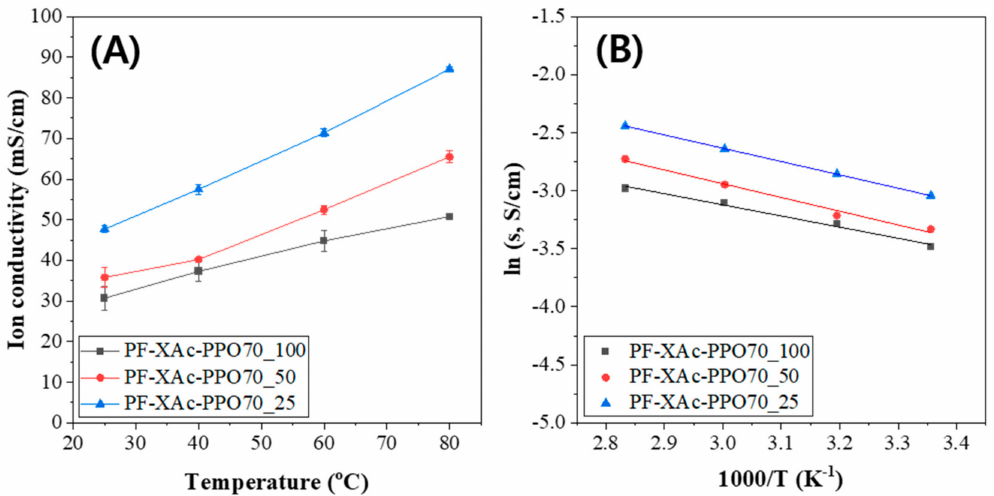
Figure 7. ( A ) Hydroxide conductivity and ( B ) Arrhenius plot of crosslinked pore-filling membranes in the temperature rising process. Table 3. Hydroxide conductivity of crosslinked pore-filling membranes.